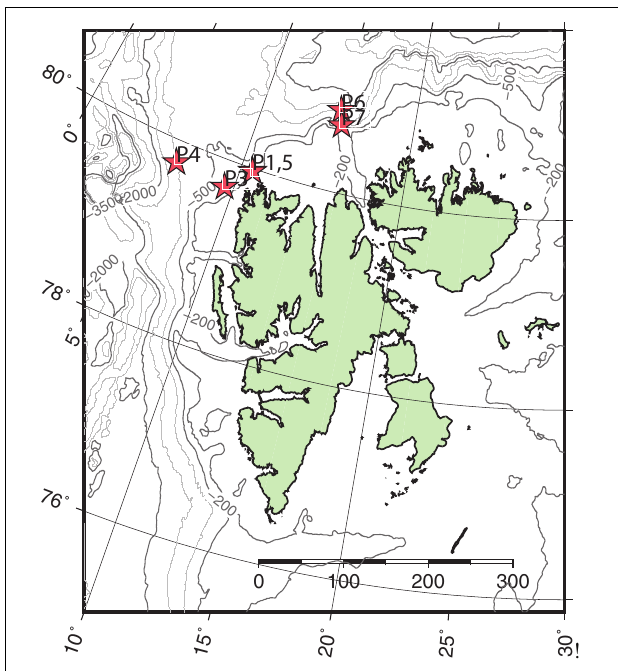
FIGURE 1 | Chart of the research area around Svalbard, with sampling stations during the two cruises in May (P1–P4) and August (P5–P7). Locations of P1 and P5 coincide. P2 is missing due to lost moorings. Scale bar in km.